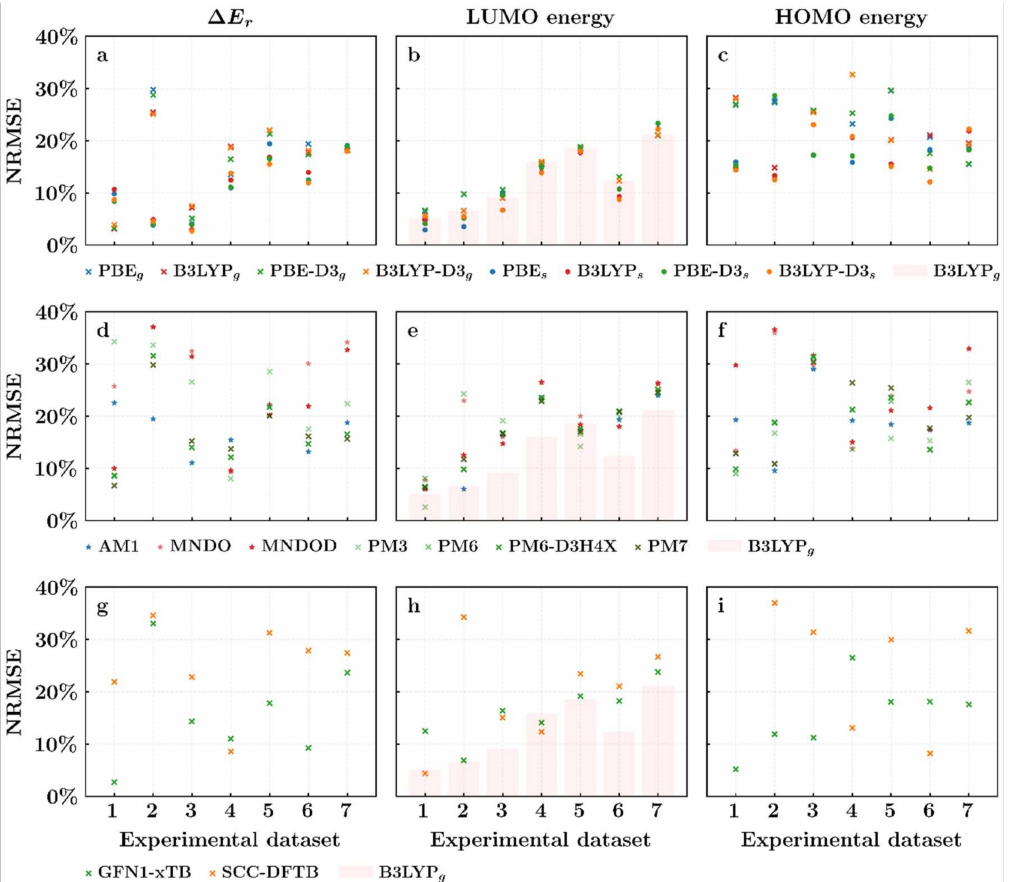
Figure 2. NRMSE of three descriptors— ∆ E r , LUMO energy, and HOMO energy—calculated with ( a – c ) DFT functionals, ( d – f ) SEQM methods, and ( g – i ) DFTB methods for the seven datasets. PBE g and PBE s represent the calculation of single point energy in the gas ( g ) and solvent phases ( s ), respectively. The shaded vertical bars in ( b , e , h ) show the fully B3LYP g calculated